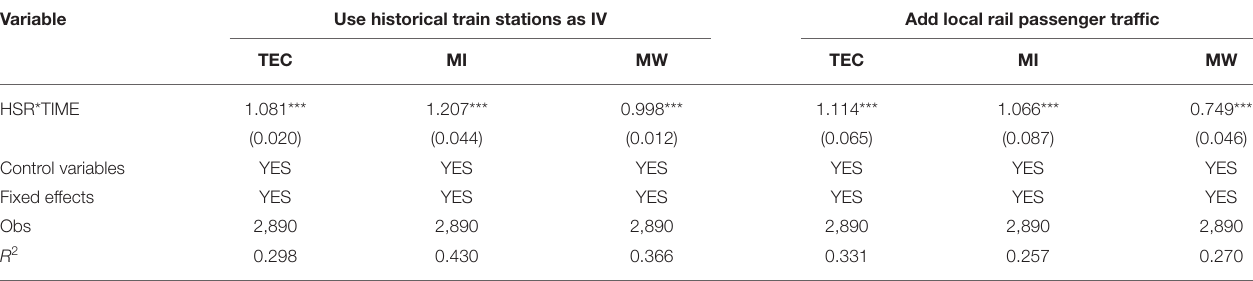
TABLE 5 | Endogeneity test.